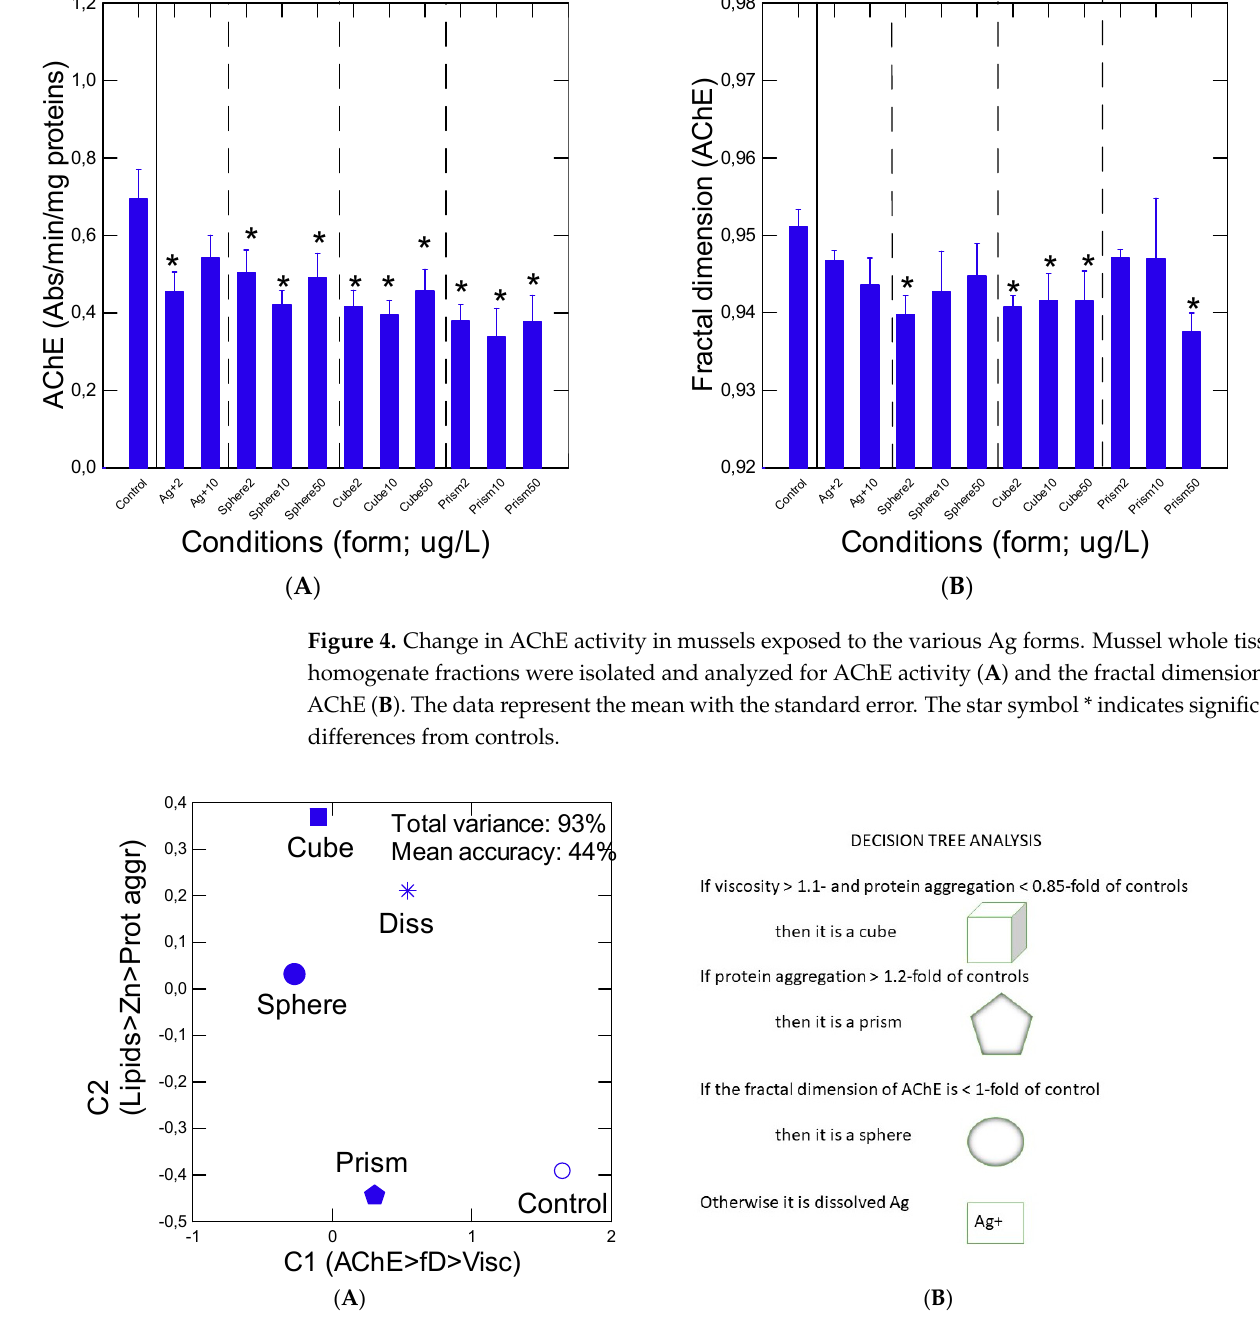
Figure 5. Discriminant function and decision tree analysis of biomarker data. The discriminant function analysis ( A ) was performed to distinguish the response patterns between the forms of Ag and the decision tree analysis was performed to determine how the specific effects could discriminate between forms. The total explained variance was 95%, with a mean classification accuracy of 45%. The mean score values are shown for controls, dissolved (Diss) and the three forms of nAg: cubes, spheres and prisms. The decision tree analysis ( B ) goes as follows: start as cubes; if viscosity >1.1-fold of controls then cubic nAg; otherwise, if protein aggregation <0.85 of controls then cube; otherwise, if protein aggregation >1.2-fold of controls then prismatic nAg; otherwise, if fD of AChE < controls then sphere otherwise it is dissolved.